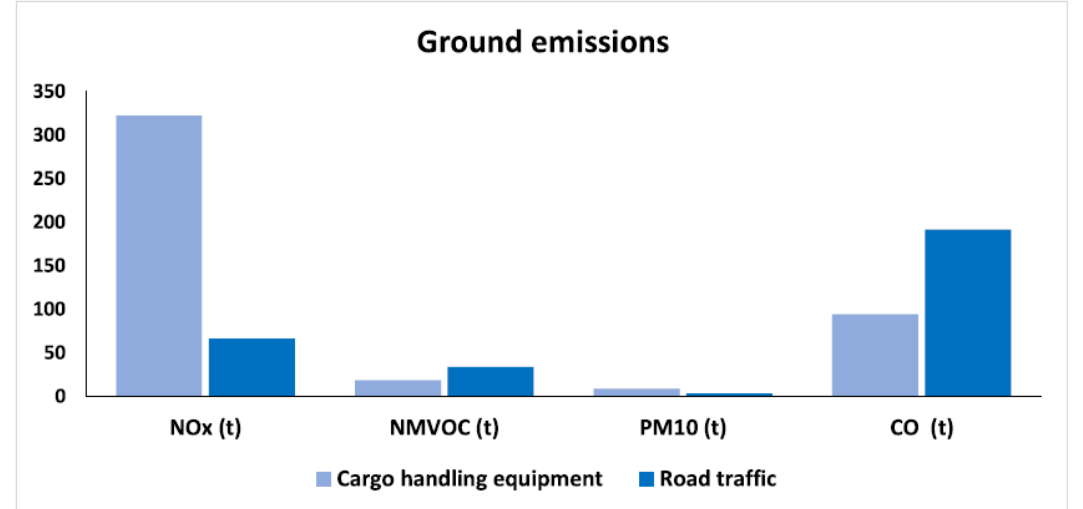
Figure 12. Annual emissions from cargo handling equipment and road traffic. Reprinted with permission from ref. [46].